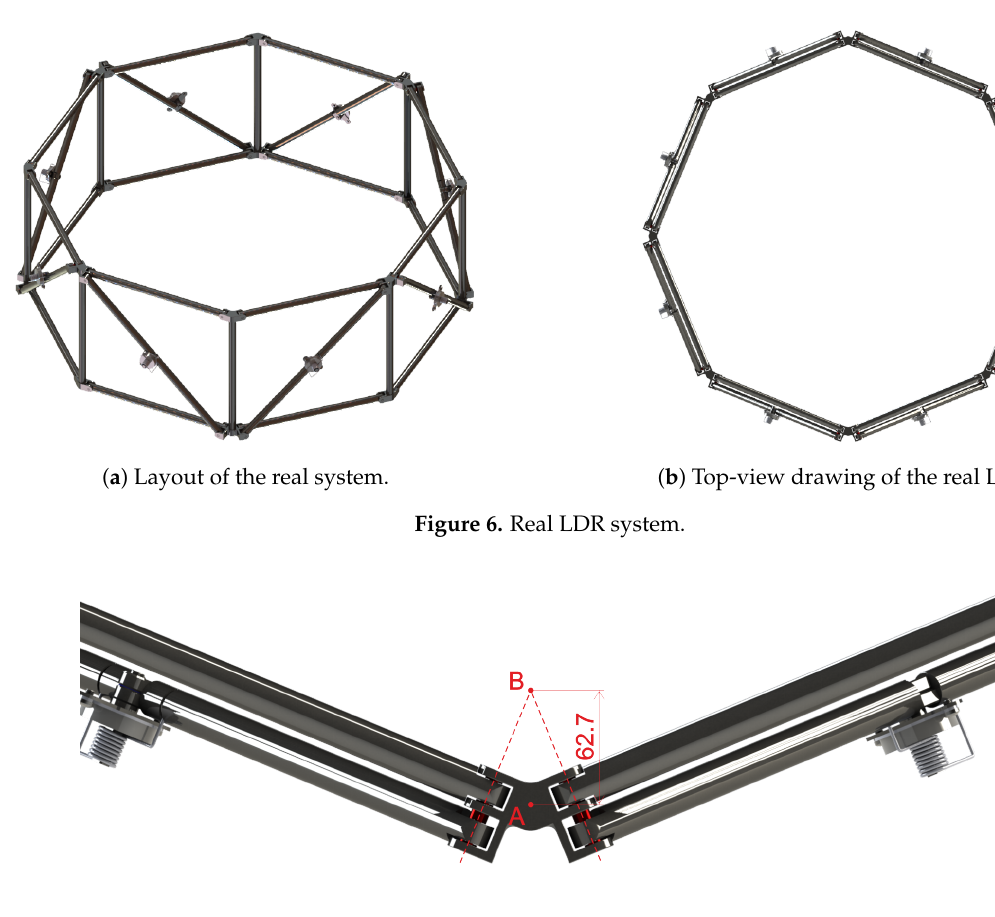
Figure 7. Distance (mm) between the center of the joints in the ideal and real designs.